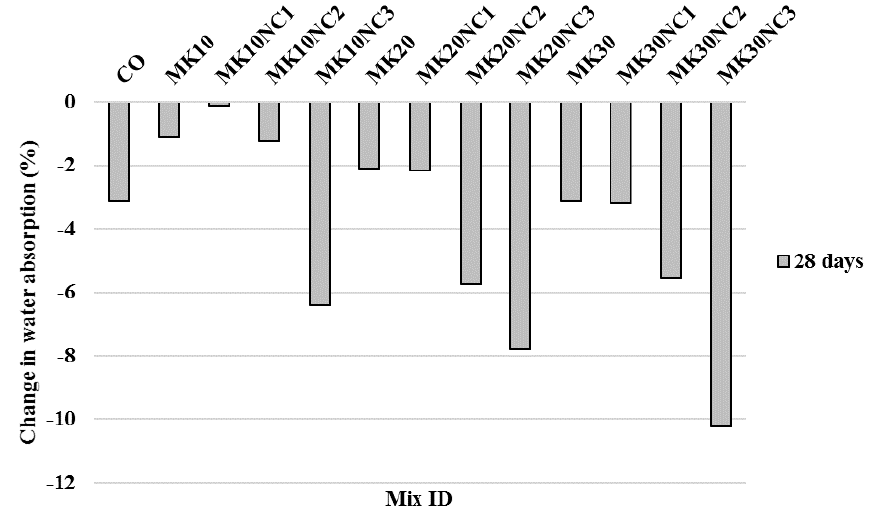
Figure 13. Percentage change in water absorption of samples by the addition of fibres at 28 days with similar volumes of MK and NC.